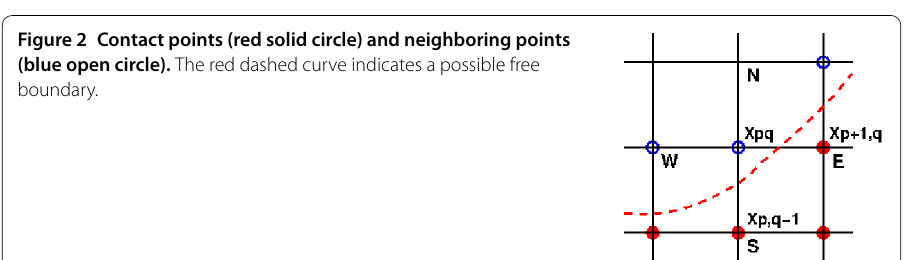
Figure 2 Contact points (red solid circle) and neighboring points (blue open circle). The red dashed curve indicates a possible free